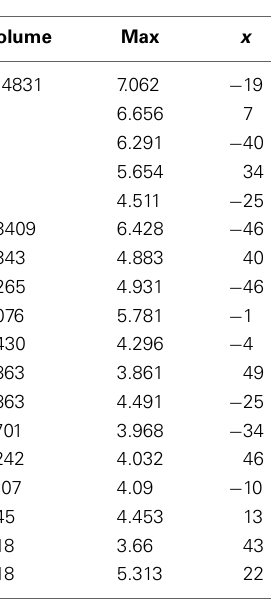
Table 4 | Talairach coordinates, volume of the cluster ( µ l), maximum z-score, and the label of anatomical structure for the consonant string text (CS) condition > fixation analysis, L, left hemisphere; R, right